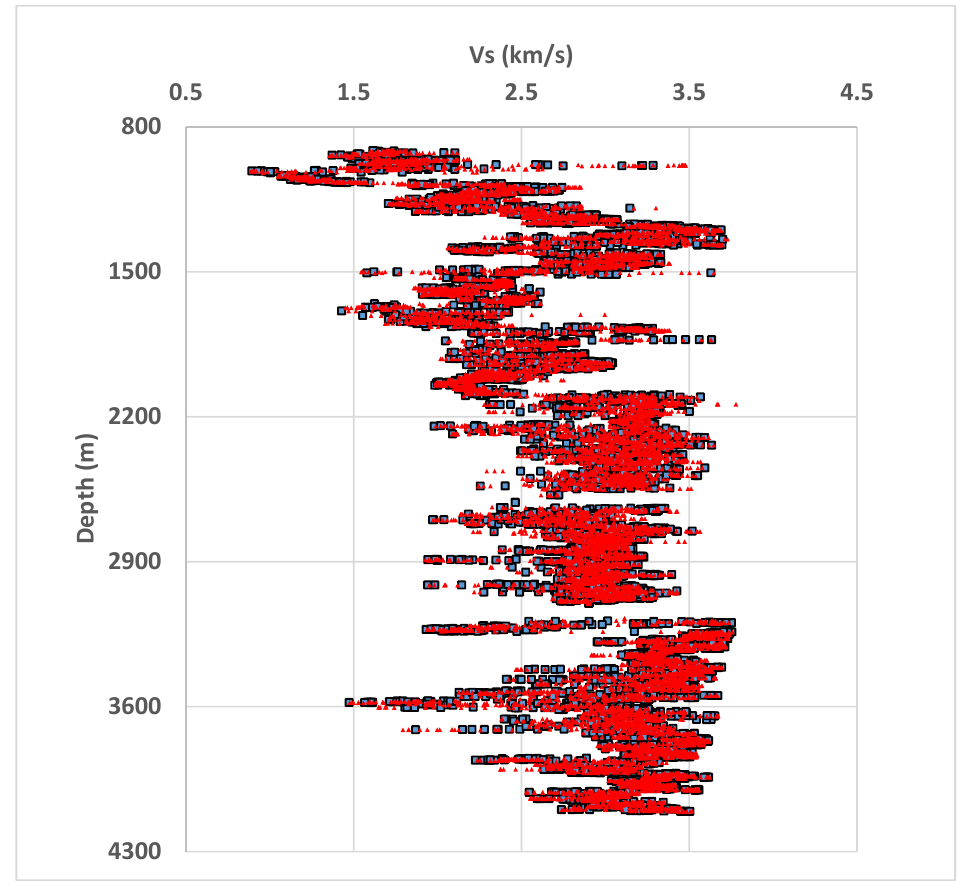
Figure 5. Training (red dots) and test (blue squares) data cover the whole well path to avoid data bias.